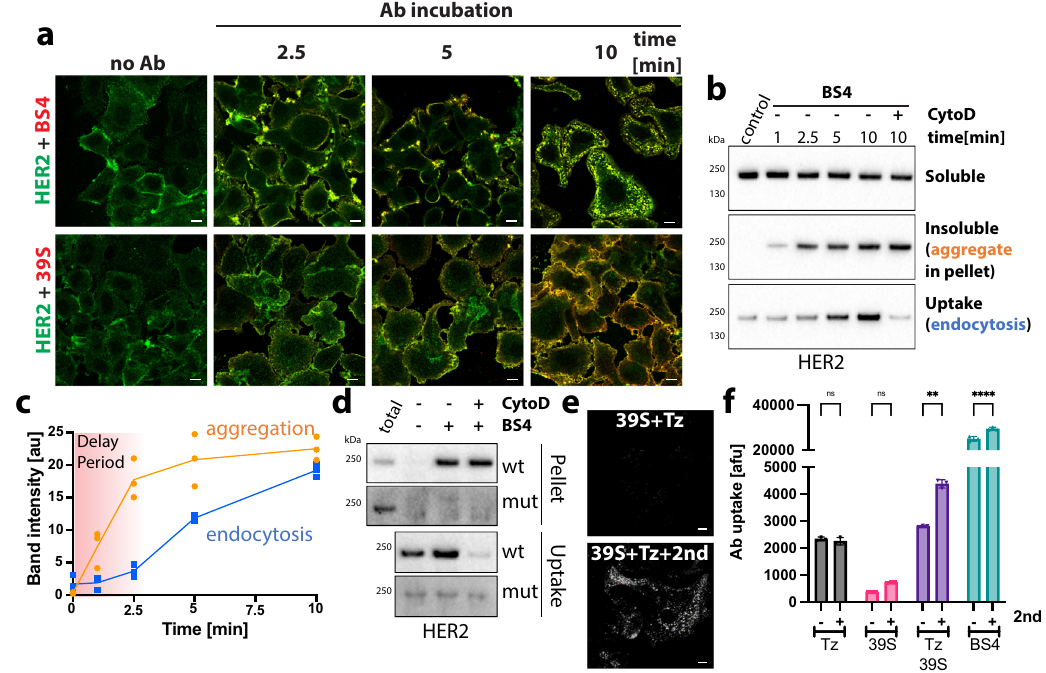
Fig. 3 | BS4-induced aggregation is the trigger for HER2 endocytosis. a BS4 clusters HER2 in the plasma membrane prior to endocytosis. SkBr3 cells were incubated with HER2-speci fi c, dylight650-labelled biparatopic antibody BS4 or monotopic antibody 39S for indicated times. After fi xation, total HER2 in cell sections was stained using an antibody against the cytoplasmic domain and sam- ples wereanalysed byconfocalmicroscopy. b , c AggregationofHER2receptorsby BS4 precedes endocytosis. After surface biotinylation, SkBr3 cells were incubated with BS4 for indicated times, surface remaining biotin was removed and samples lysed in low detergent buffer. A fraction was spun to separate soluble (Sup) from insoluble/aggregated proteins (Pellet). Protein in the remaining sample was solu- bilised (see “ Methods ” for protocol) and endocytosed biotinylated proteins con- centrated on Streptavidin beads (uptake). Samples were assayed by immunoblot for the HER2 protein ( b ). c Time dependence of BS4-triggered aggregation and